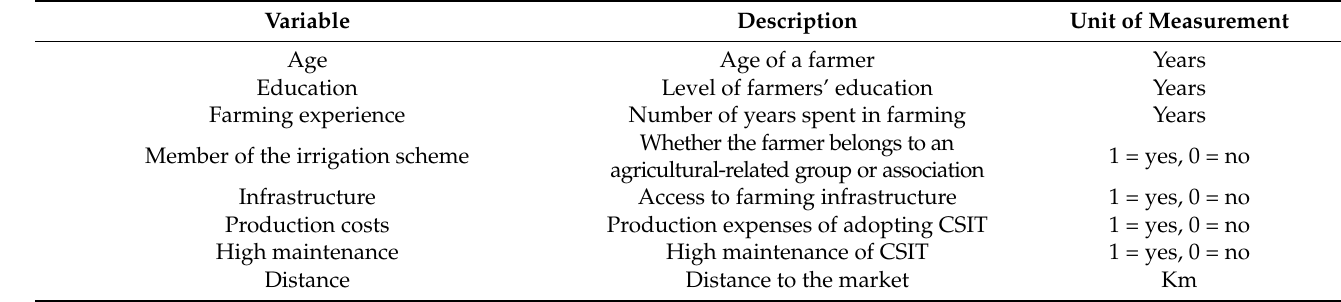
Table 5. Description of variables in the multinomial logistic regression